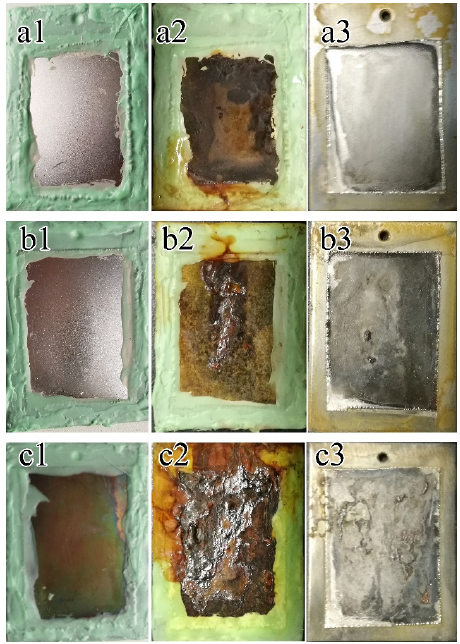
Figure 7. Corrosion results of samples deposited under DC. ( a1 ) as deposited; ( a2 ) as deposited after 1000 h test; ( a3 ) as deposited with corrosion product removed; ( b1 ) 300 °C treated; ( b2 ) 300 °C treated after 1000 h test; ( b3 ) 300 °C treated with corrosion product removed; ( c1 ) 400 °C treated; ( c2 ) 400 °C treated after 1000 h test; ( c3 ) 400 °C treated with corrosion product removed.